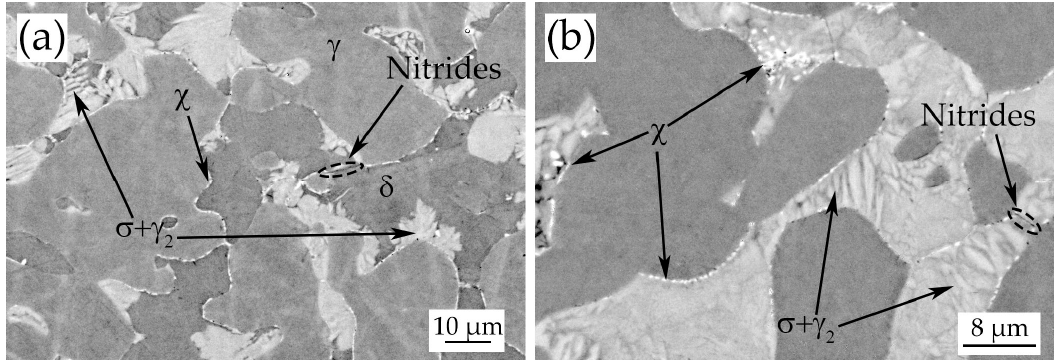
Figure 2. After heat treatment at 850 °C for: 10 min ( a ) and 25 min ( b ).